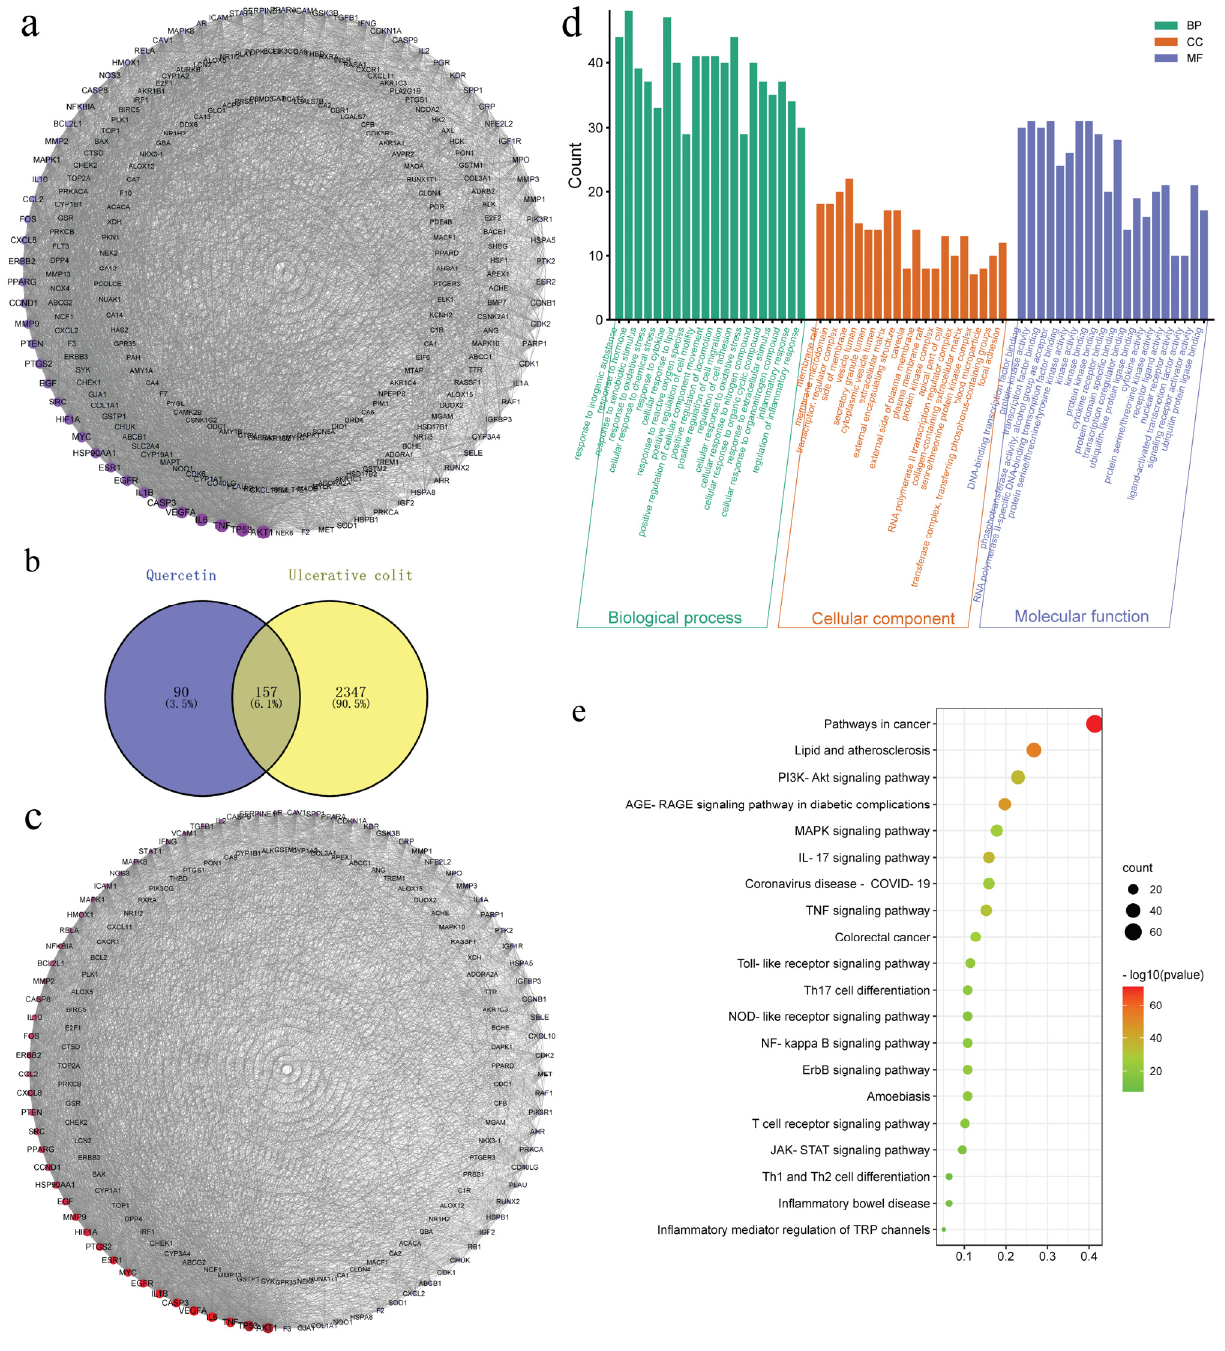
Figure 3. Network analysis of quercetin. ( a ) Protein-protein interaction (PPI) network diagram of quercetin-related proteins. ( b ) Venn diagram showing the intersection between ulcerative colitis (UC) and quercetin. ( c ) PPI interaction network of quercetin and UC intersection targets. Gene ontology ( d ) and Kyoto Encyclopedia of Genes and Genomes (KEGG) pathway enrichment ( e ) analysis.